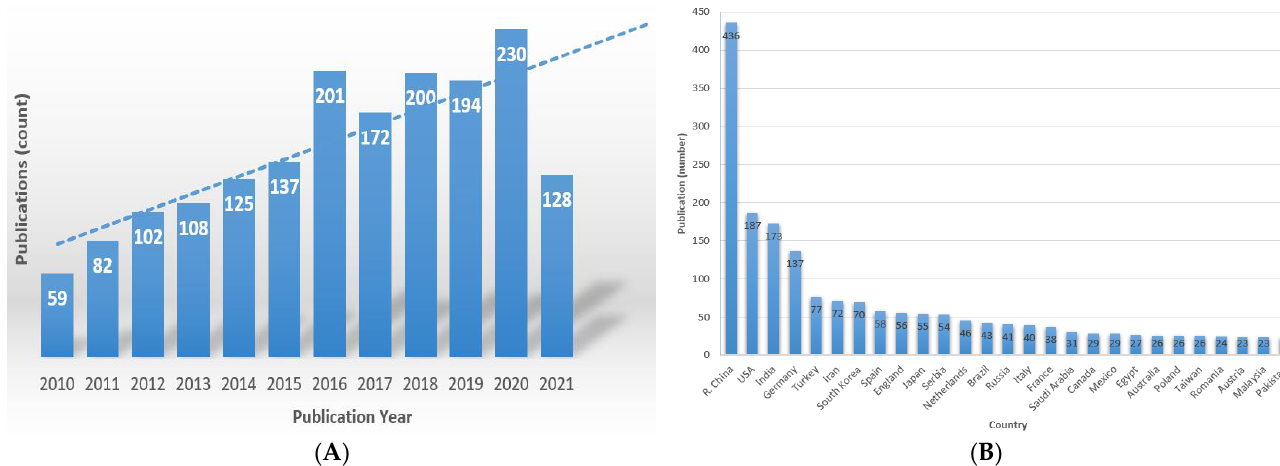
Figure 2. IA-related articles published between 2010 and august 2021 through search results within search text “itaconic acid” were achieved using Web of Science Core Collection from 6 August 2021. ( A ) Total publication count and the escalating trendline; ( B ) Publications/Country (the first 20 Countries/publication are shown).